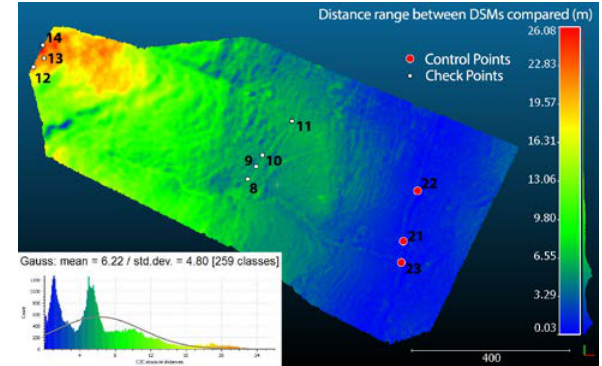
Figure 10. Scenario (d) Distance range comparison and Gauss curve fitting on distance difference histogram values (units in m) Min=0.03 / Max=26.08 / Mean=6.22 / Std. Dev.=4.80